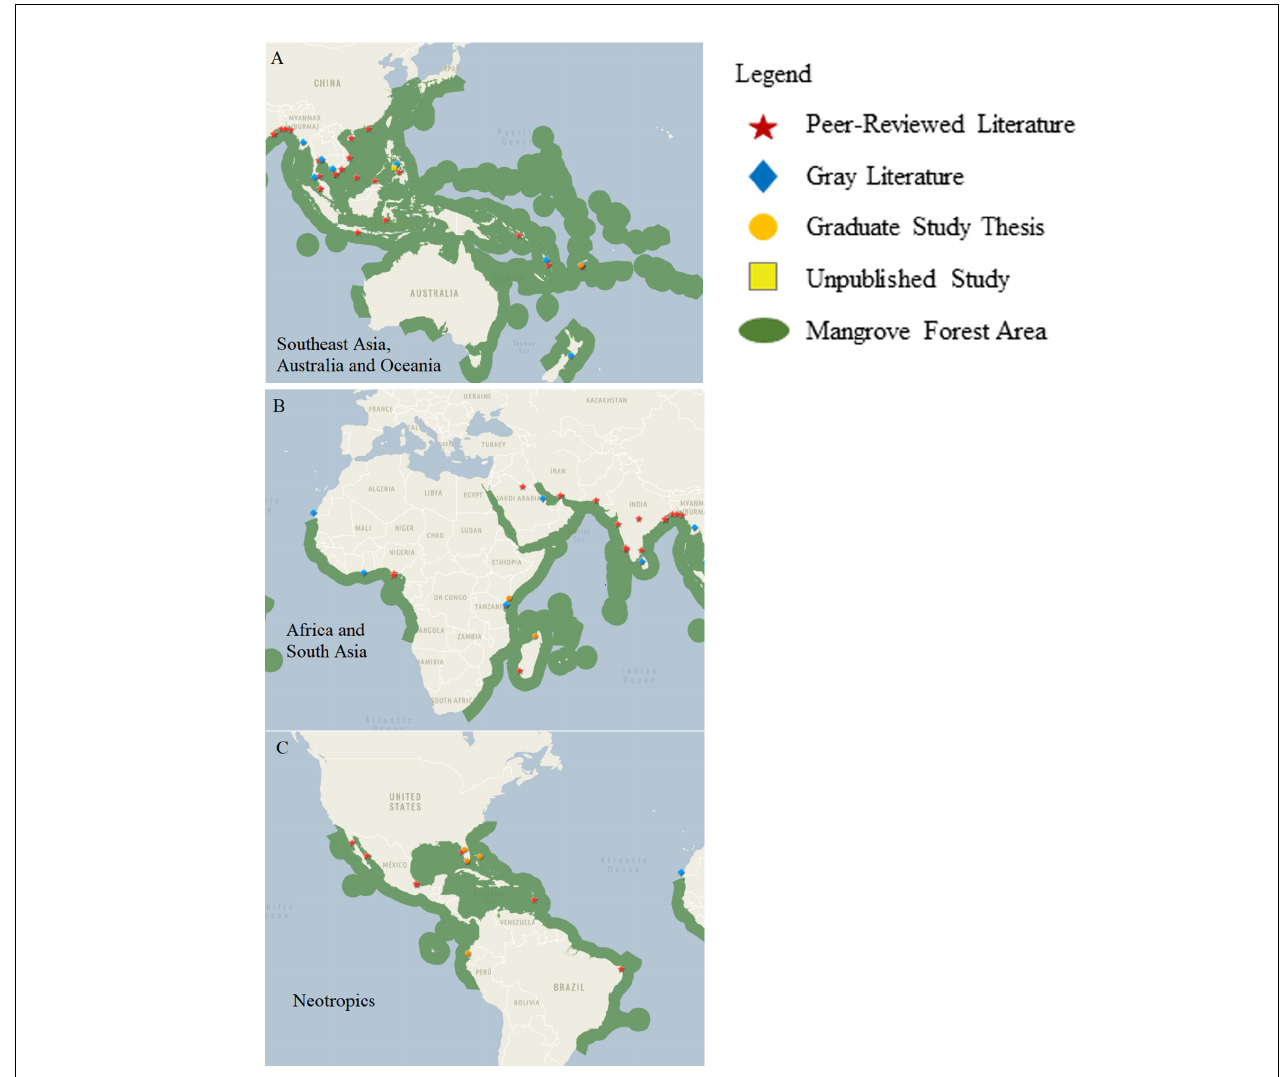
FIGURE 1 | Global distribution of mangrove forests and local site specific mangrove valuation studies published between 2007 and 2016 in (A) southeast Asia, Australia and Oceania, (B) Africa and South Asia and (C) the Neotropics. Source for the mangrove forest distribution layer: Spaulding et al. (in preparation).